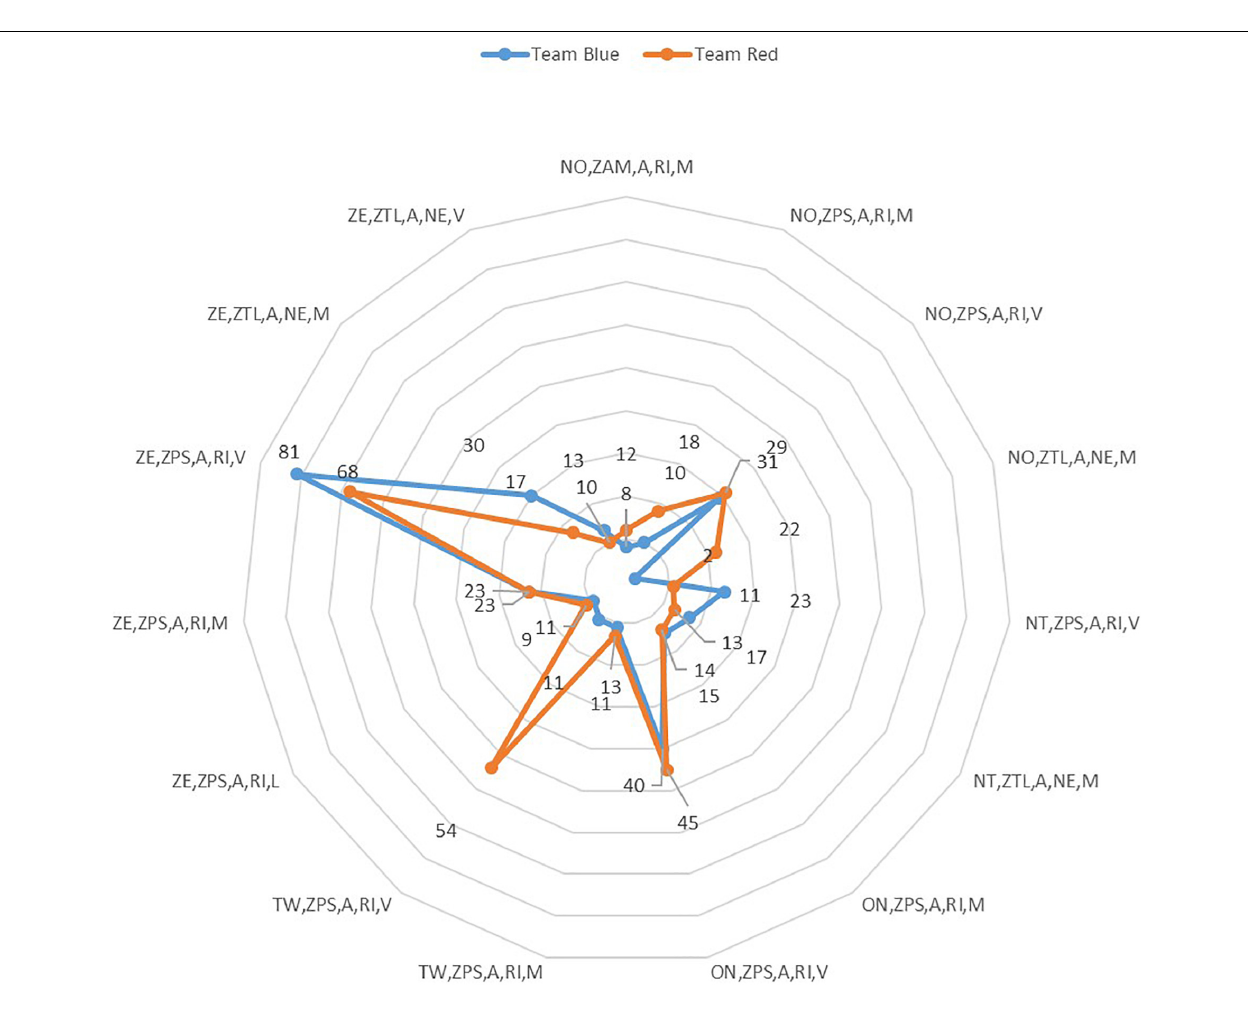
ze, zps, a, ri, v) ( n = 13; ze, ztl, a, ne, m), two sets were identified in the red team ( n = 20; no, ztl, a, ne, m) and ( n = 43; tw, zps, a, ri, v).